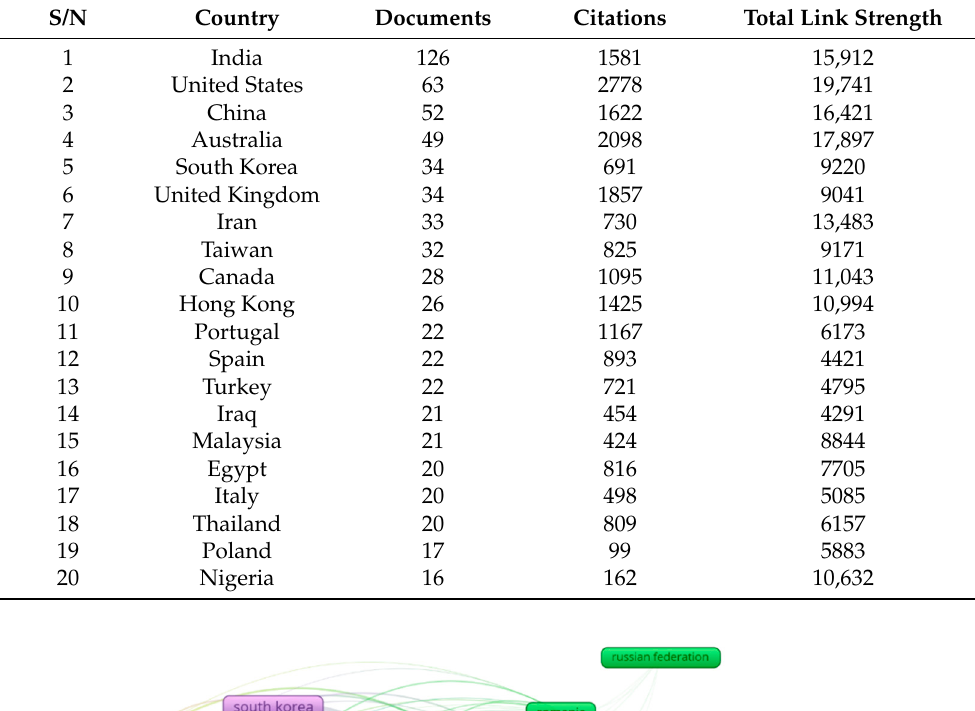
Table 5. Top 20 contributing countries.